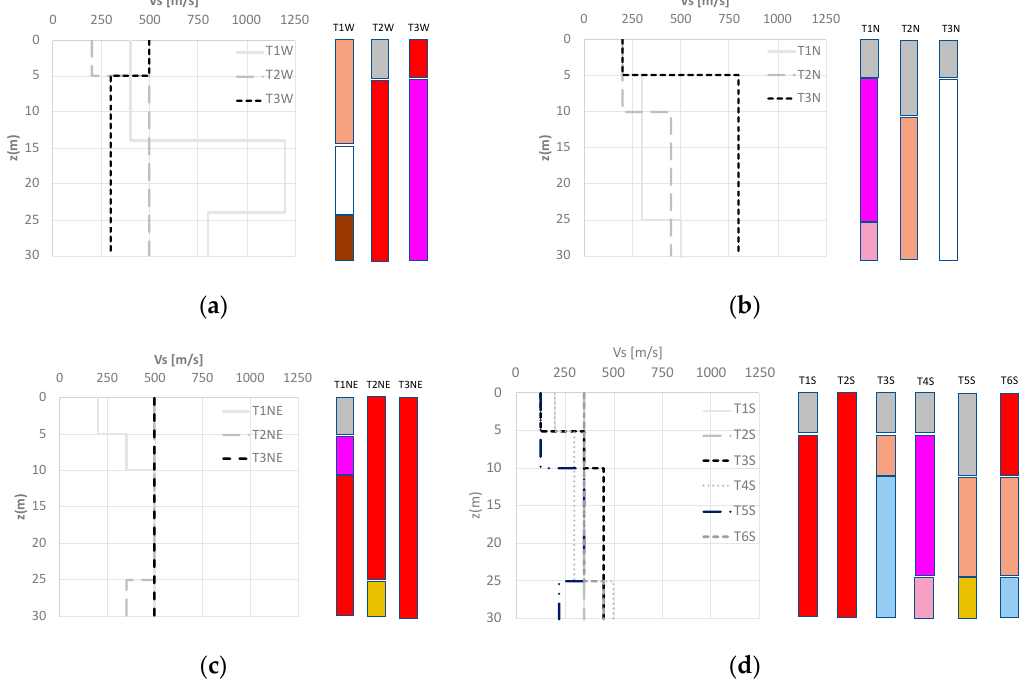
Figure 5. Profile of V s for all the considered sub-areas of the four investigated areas and corresponding stratigraphies: ( a ) west area; ( b ) northeast area; ( c ) north Old Town; ( d ) south Old Town. Table 2. Main properties of the utilized inputs.